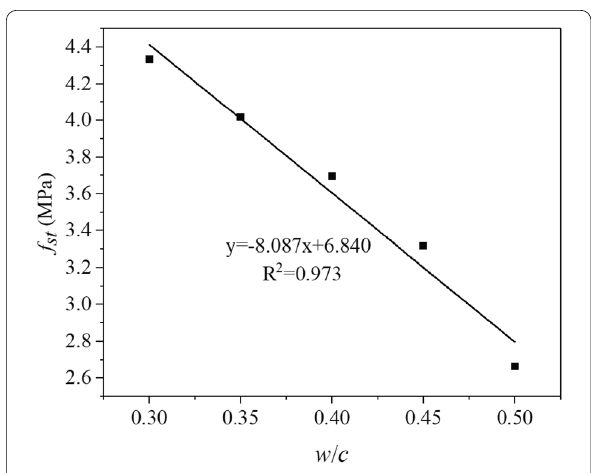
Fig. 15 Variation of dissipated fracture energy with mortar water– cement